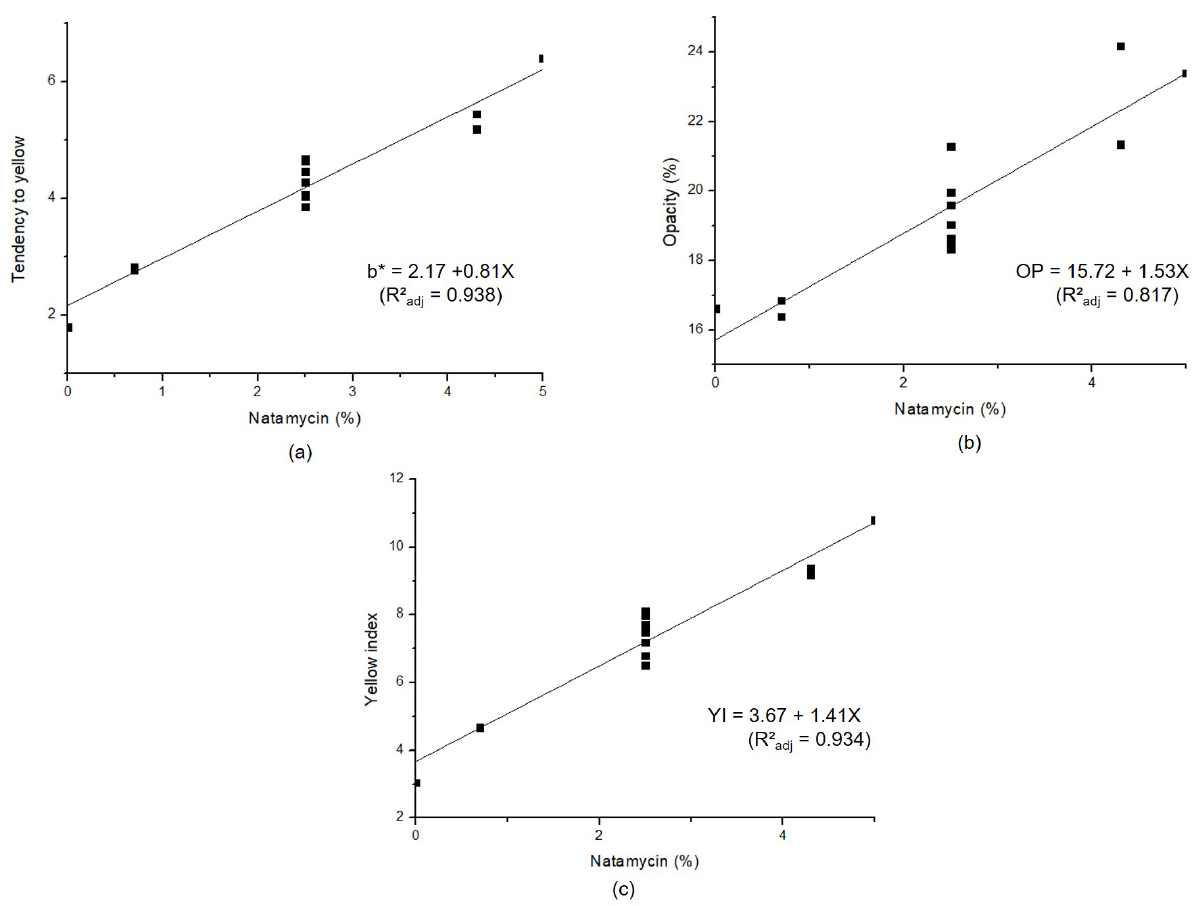
Figure 2. Plots of optical parameters as a function of natamycin concentration (% wt./wt., represented by X), their regression model, and adjusted R²: tendency to yellow (b*, a ), opacity (OP, b ), and yellow index (YI, c ).